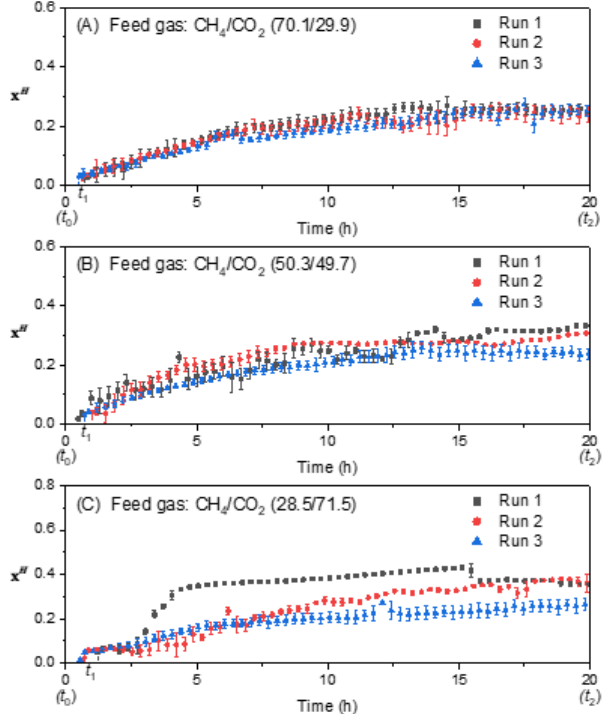
Figure 6. The evolution of the fraction of hydrate x H contained within the gel for three different gas compositions. ( A ) feed gas methane fraction 0.701, ( B ) feed gas methane fraction 0.503 and ( C ) feed gas methane fraction 0.285.